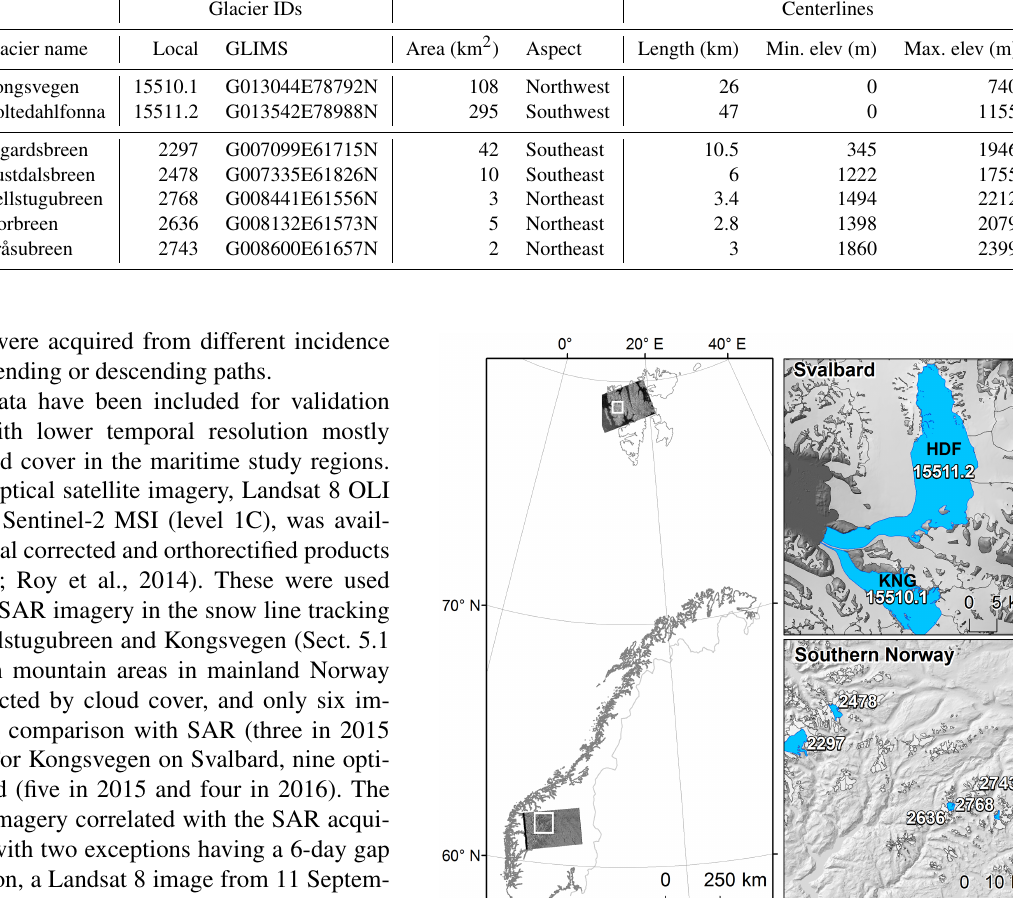
Table 1. Basic glacier information from Nuth et al. (2013) and Andreassen et al. (2012). Glacier IDs